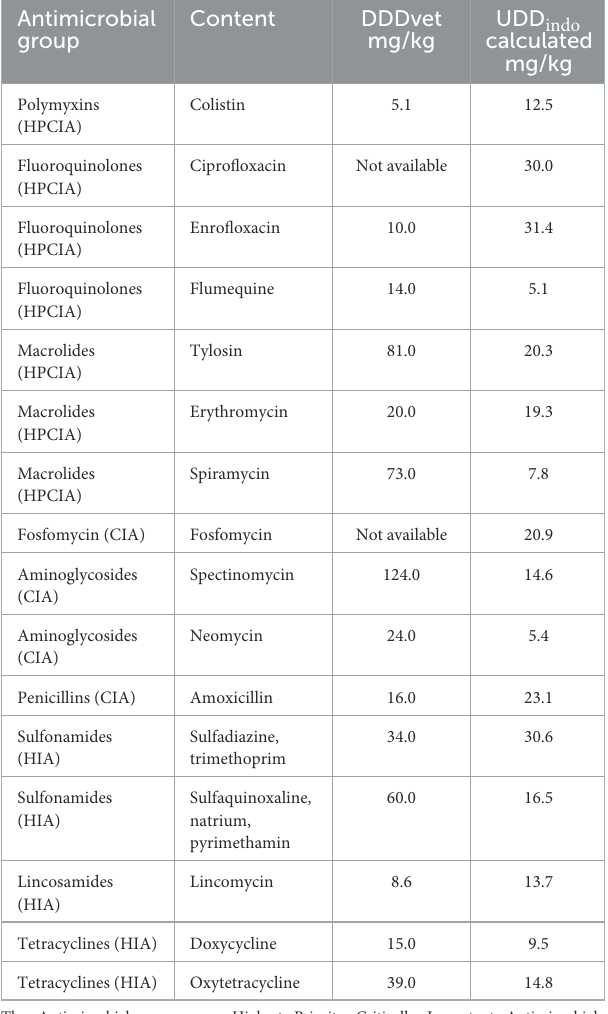
TABLE 1 Overview of defined DDDvet and calculated UDDindo values used to calculate TF DDDvet and TF UDDindo respectively per production cycle. Antimicrobial